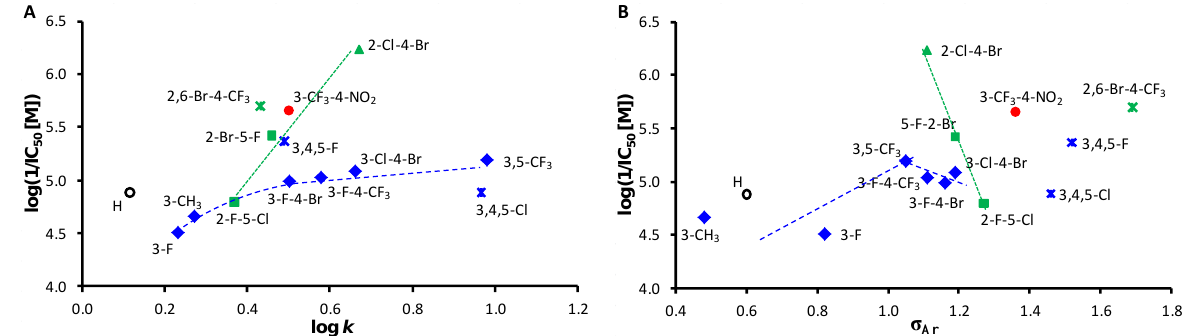
Figure 3. Relationships between in vitro activity against P. falciparum log(1/MIC [M]) and lipophilicity expressed as log k ( A ) and electronic σ parameters of substituted anilide ring ( B ) of studied compounds. (Black = unsubstituted derivative 1 , blue = meta/para -substituted derivatives, red = nitro-substituted derivative, green = ortho -substituted derivatives or derivatives with any ortho -substitution.)